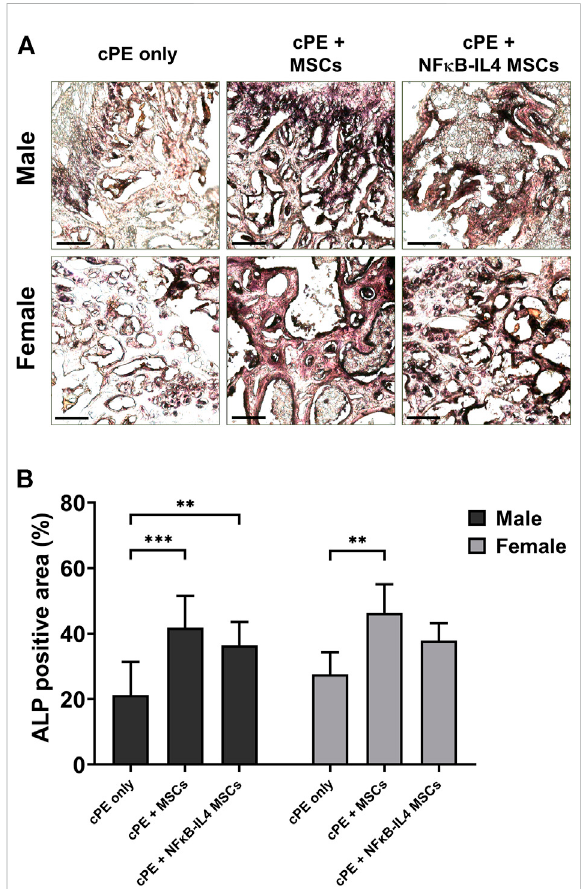
FIGURE 5 ALP staining analysis of harvested sample at 6 weeks. (A) representative images of ALP staining, black colored space is ALP positive area. Scale bar = 100 μ m. (B) quantitative analysis of ALP positive area percentage. Males had signi fi cant increased ALP positiveareainbothMSCsandNF κ B-IL4MSCsgroups.Whereasin females, only unaltered MSC group showed a statistically signi fi cant increase. (Males, cPE only group: n = 7, cPE + MSCs group: n = 8, cPE + NF κ B-IL4 MSCs group: n = 9; Females, cPE only group: n = 5, cPE + MSCs group: n = 7, cPE + NF κ B-IL4 MSCs group: n =5;** p < 0.01,*** p < 0.001,Two-wayANOVAcompared to sex-matched groups).